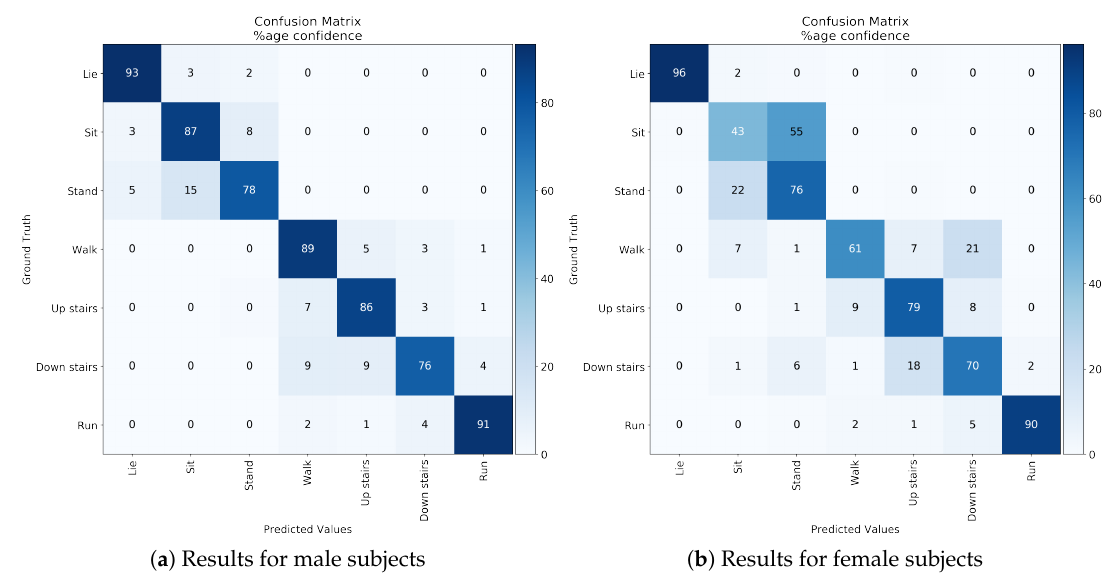
Figure 13. Effects of gender differences on recognition results (leave-one-person-out cross-validation).